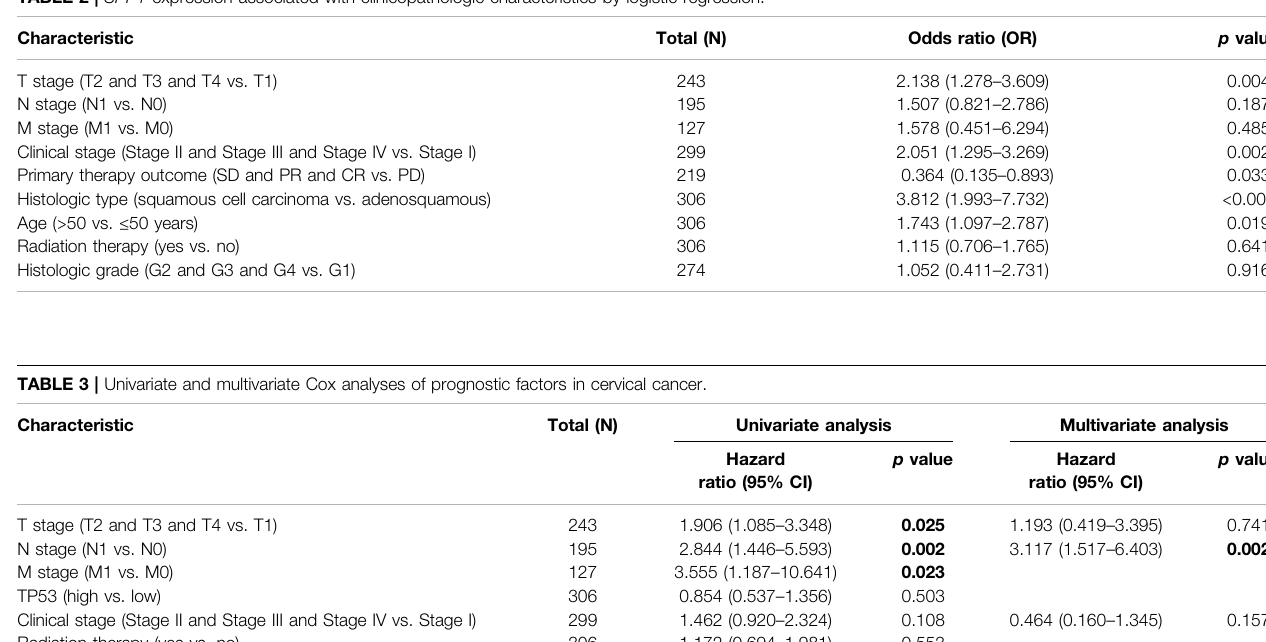
T stage (T2 and T3 and T4 vs. T1)